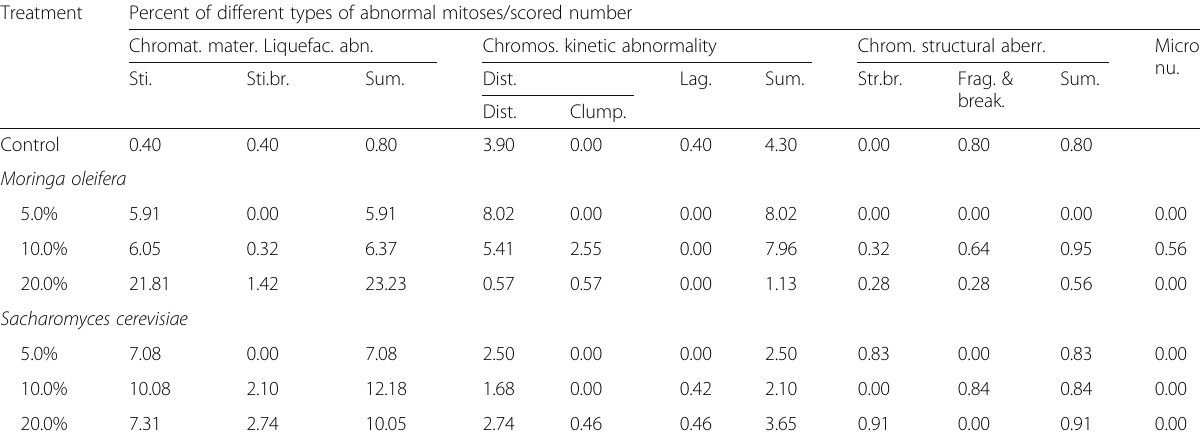
Table 2 Percentage of the different types of abnormalities/scored number, occurring in the mitoses of Allium cepa root tip meristems, after 3 h treatment with Moringa oleifera and Sacharomyces cerevisiae extract Treatment Percent of different types of abnormal mitoses/scored number Chromat. mater. Liquefac. abn. Chromos. kinetic